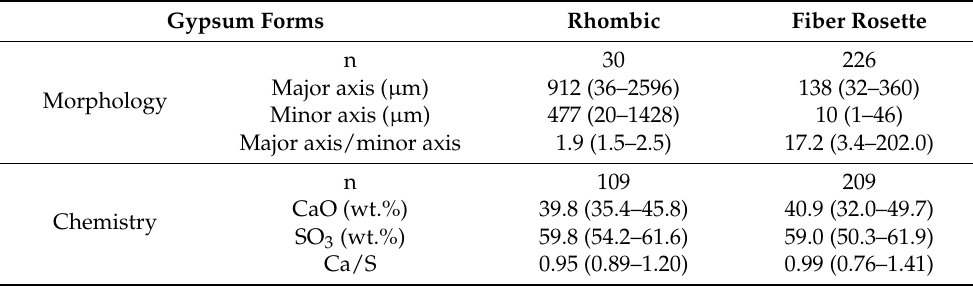
Figure 4. ( A ) Photograph of separated grains (> 250 µ m) from the ARAON Mound. Rhombic and fibrous grains are gypsum, and most of the others are quartz and feldspar. ( B – D ) SEM images of gypsum crystals from ARAON Mound. ( B ) Rhombic form, ( C ) tabular form, ( D ) fiber rosette form, ( E ) plate by the growth of fibers. Table 4. Morphology and chemistry of gypsum from the ARAON